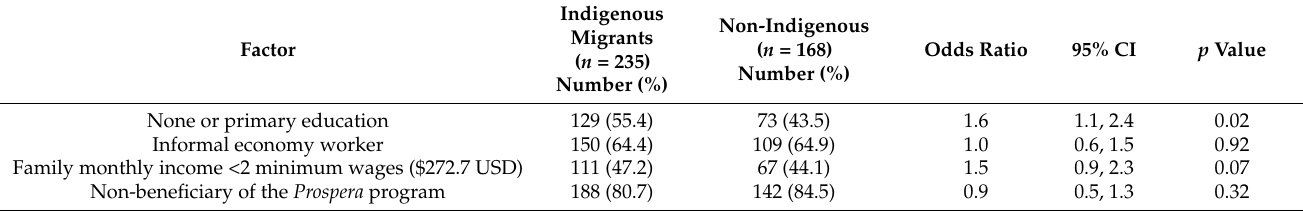
Table 1. Structural determinants of health according to indigenous migrant and non-indigenous category.